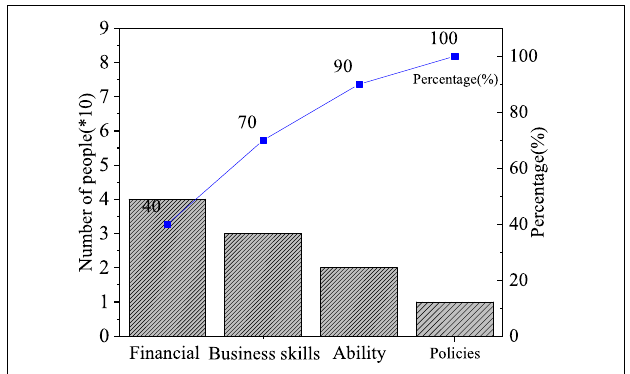
FIGURE 4 | Factors of entrepreneurial failure.